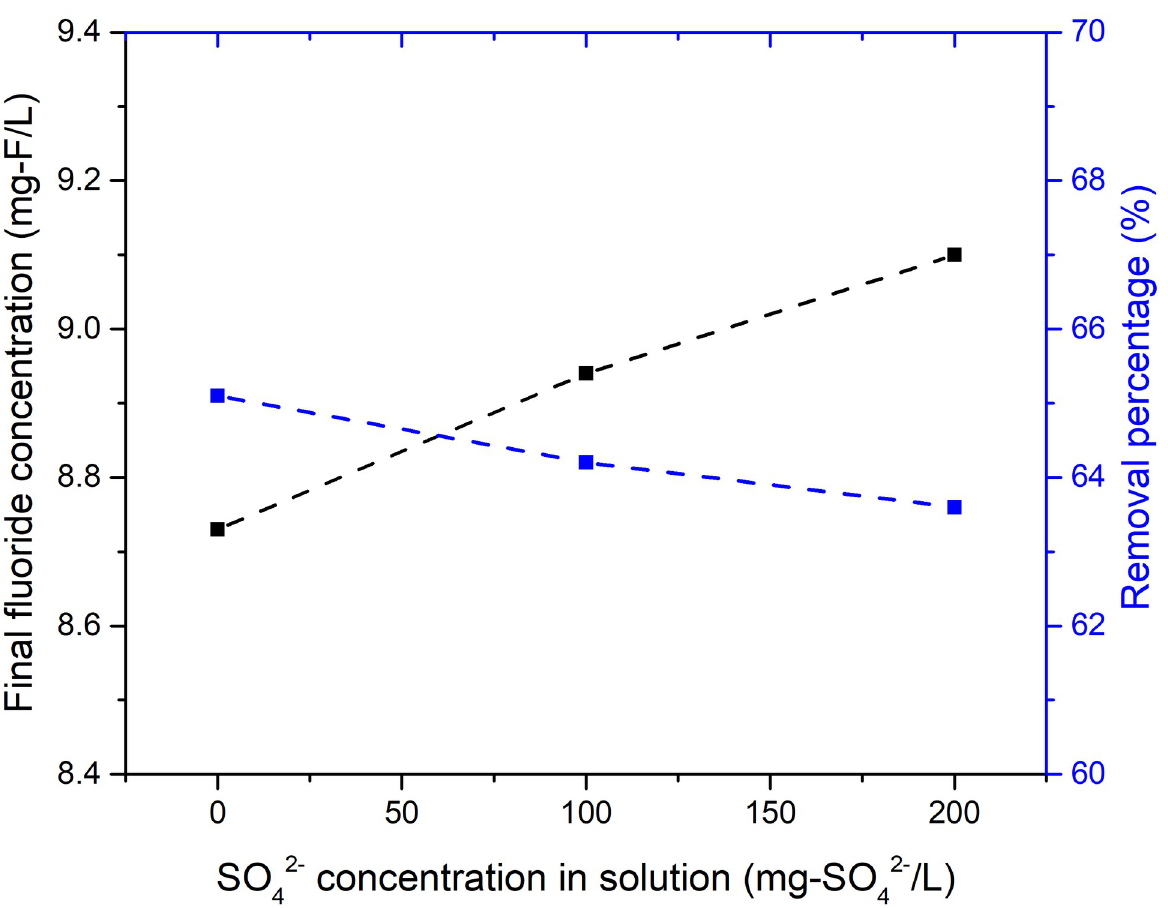
Fig 7. Influence of SO 42- concentration in solution on fluoride